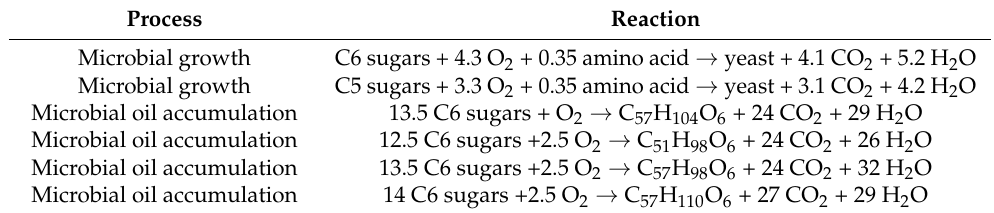
Table 1. Reactions included in the simulation model.